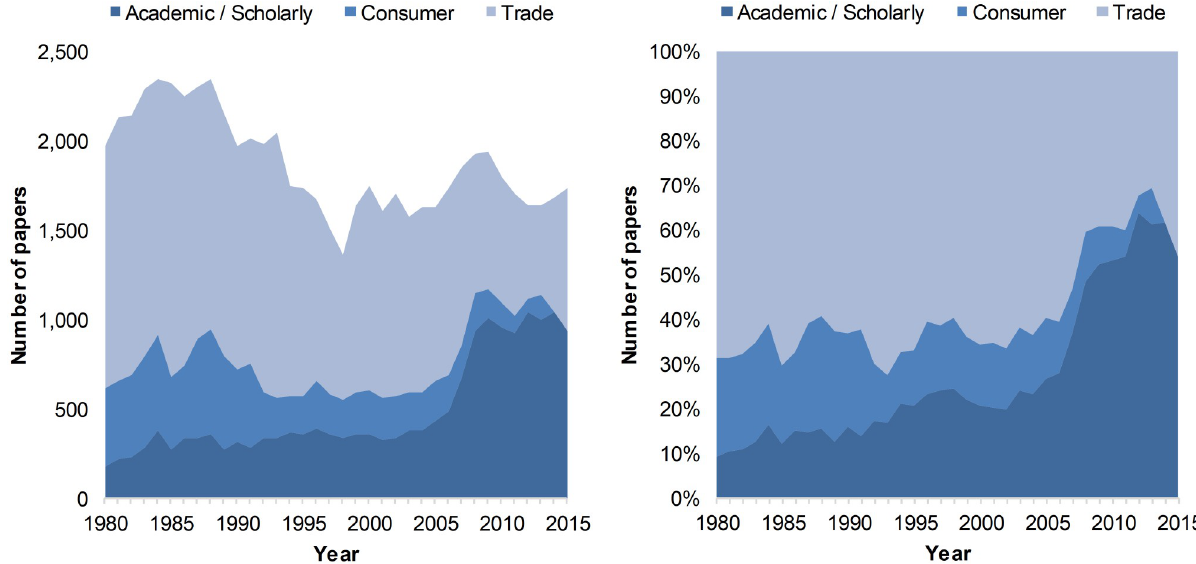
Fig 2. Number (left) and proportion (right) of papers devoted to architecture published worldwide, by year of publication and journal type, 1980–2015.